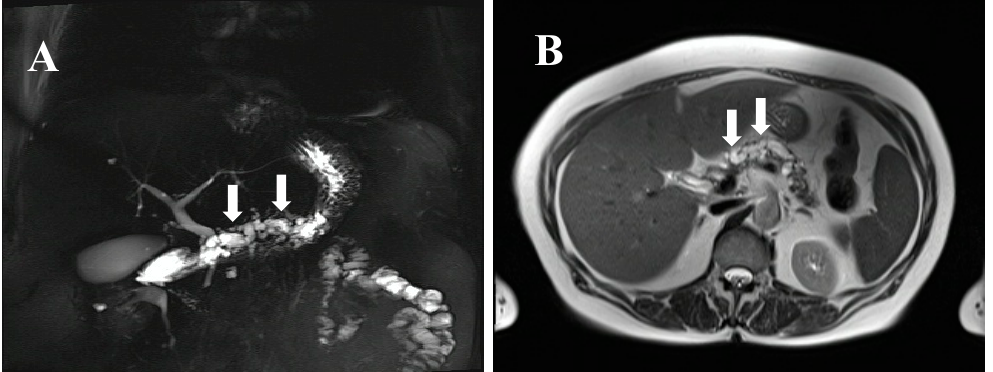
Figure 1. MRCP (magnetic resonance cholangiopancreatography) ( A ) and MRI (magnetic resonance